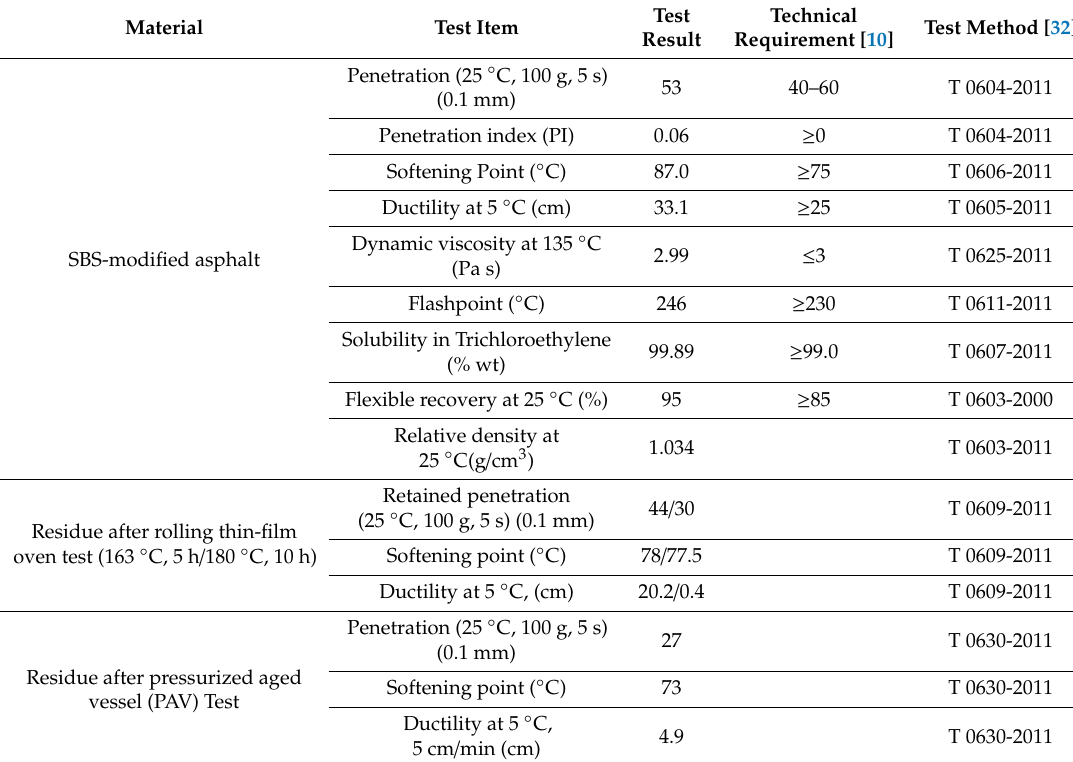
Table 1. Conventional properties of modified asphalt and test results of residues after